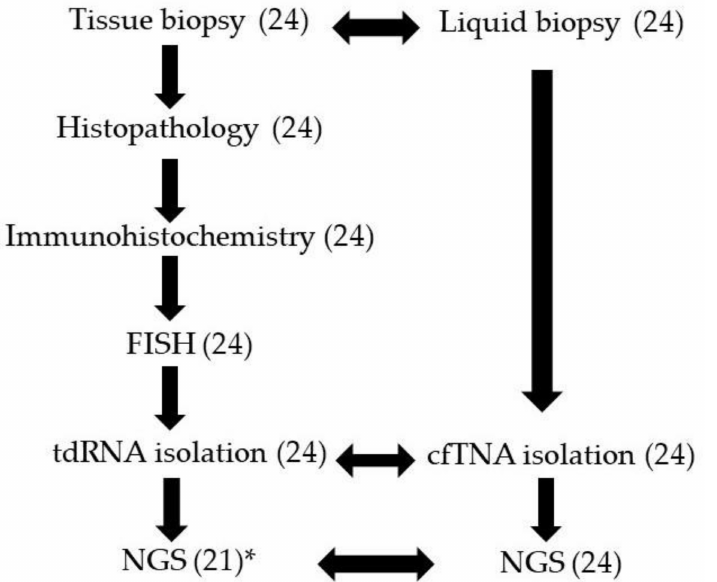
Figure 1. The study workflow of samples from 24 aggressive lymphoma patients. Analyzed sample numbers are indicated in parentheses. *: tdRNA yields were insufficient for NGS (Cases 2, 8, and